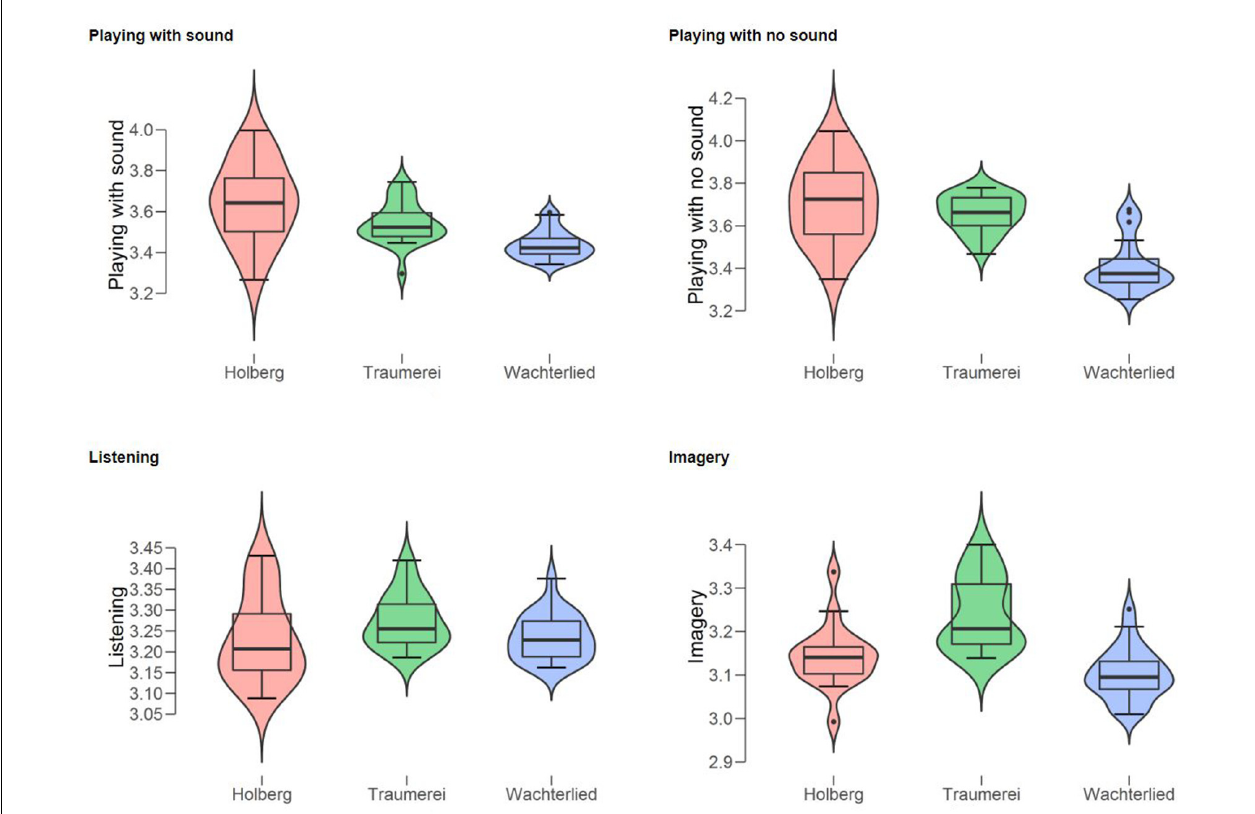
had still positive correlations, but with Spearman’s coefficients r below 0.5, accounting for less than a quarter of the variance and are not displayed here.